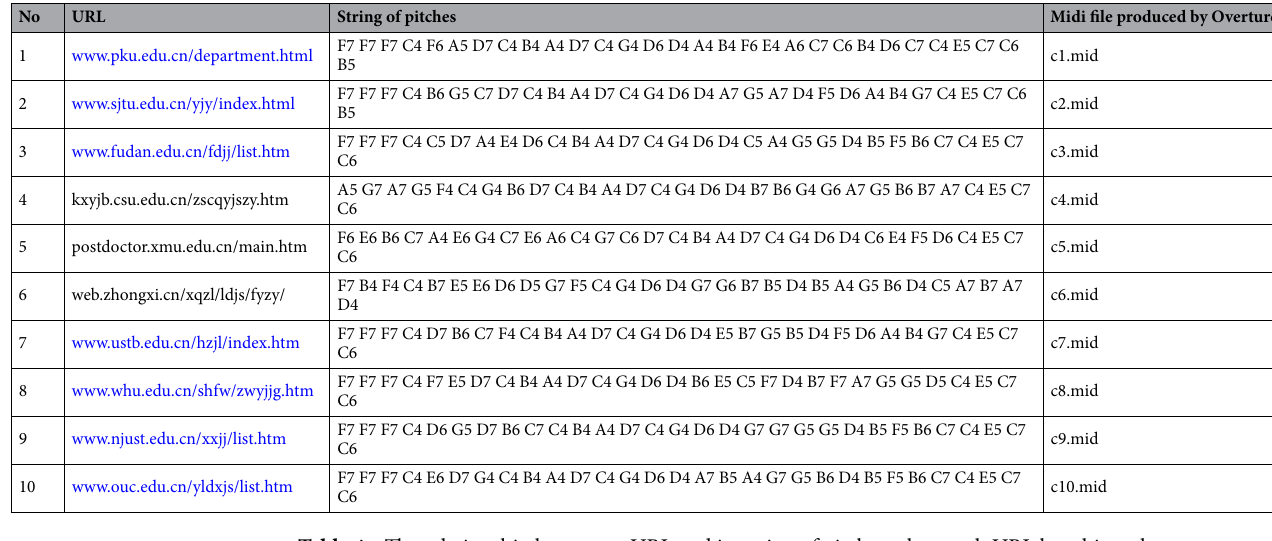
Table 4. The relationship between a URL and its string of pitches when each URL has thirty characters.